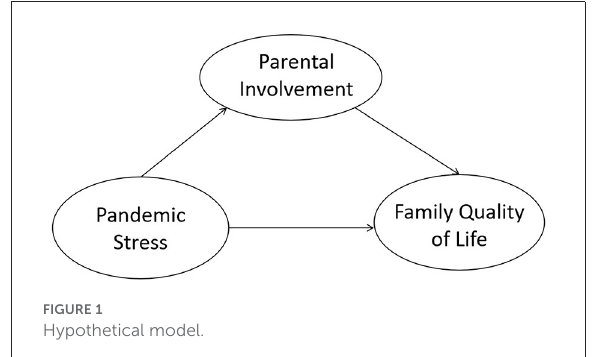
FIGURE1 Hypothetical